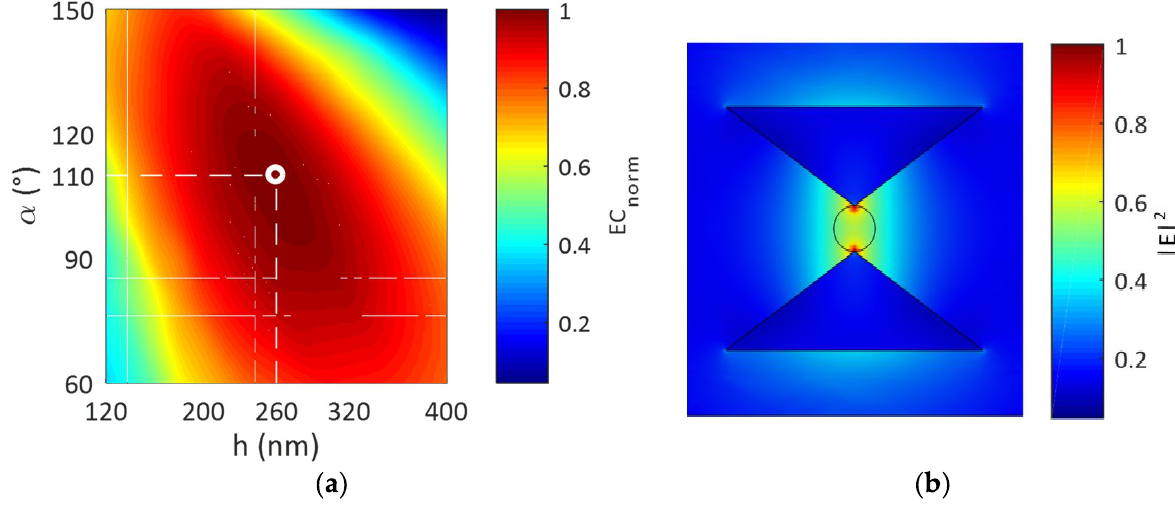
Figure 2. ( a ) 3D representation of EC norm , by considering P norm = 1 mW/ µ m 2 ; ( b ) electric field distribution for the proposed dielectric bowtie with t = 220 nm, α = 110 ◦ , h = 260 nm, and g = 120